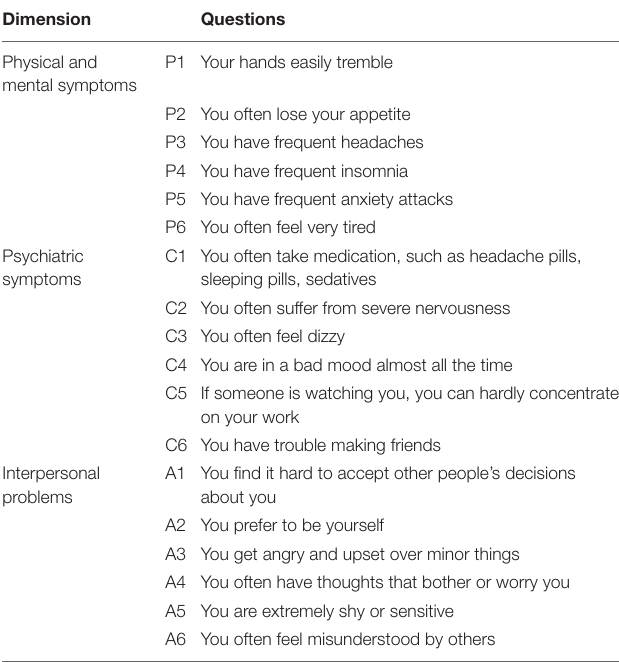
TABLE 1 | Measure scale of community residents’ mental